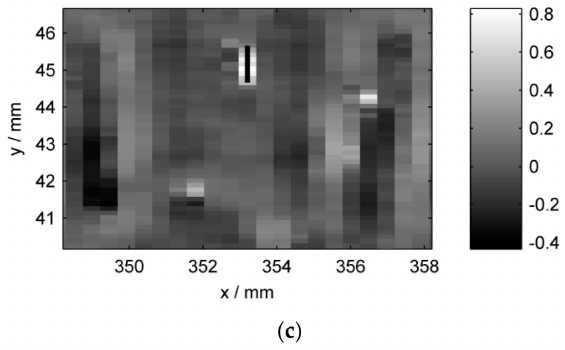
Figure 5. Preprocessed sensor intensity images, zoomed to a region around the groove nr. 13. Higher intensities correspond to indications. ( a ) ET; ( b ) MFL; ( c ) TT. The vertical black line marks the location of the groove. Each image is shown in the respective sensor’s coordinate system, thus explaining the different spatial axis labels.